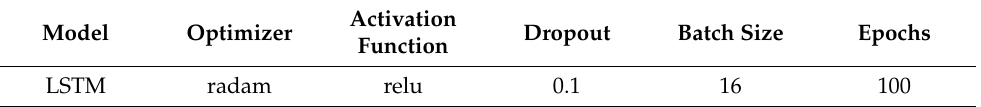
Table 4. Parameters of the ANN algorithm.